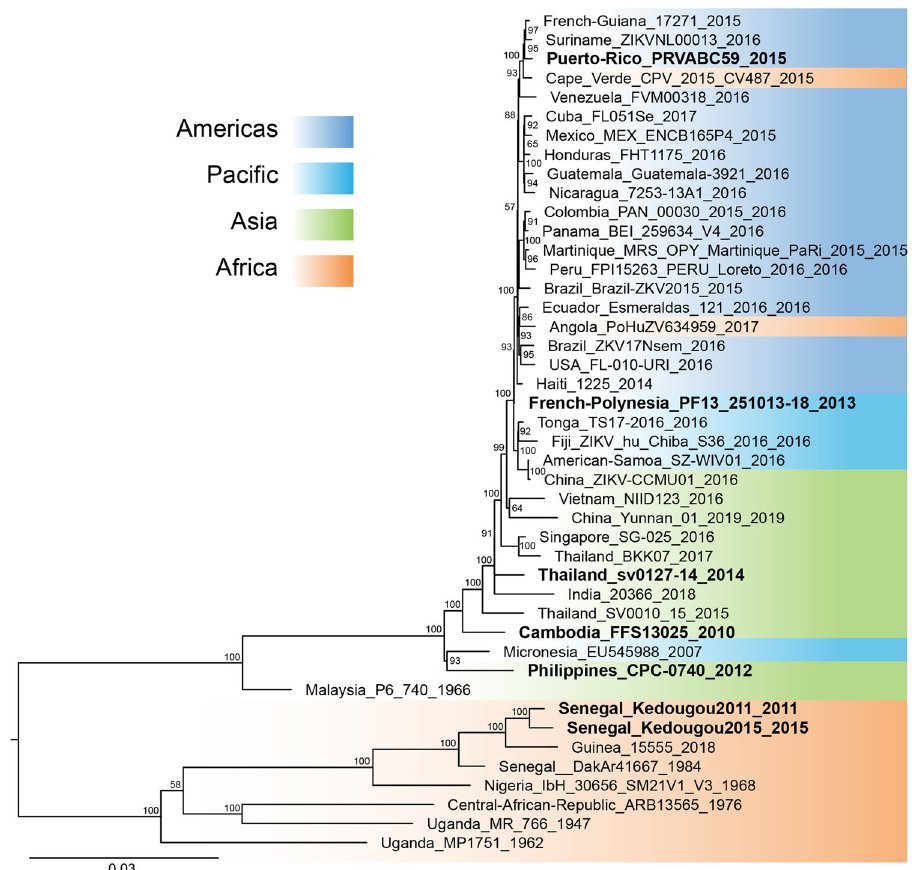
Fig. 1 Phylogenetic position of ZIKV strains used in this study. The phylogenetic tree shows the seven ZIKV strains of the panel (in bold) among a backdrop of ZIKV strains spanning the current viral genetic diversity. The colored background represents the geographic origin of ZIKV strains. The consensus tree was generated from 1000 ultrafast bootstrap replicate maximum-likelihood trees, using a GTR + F + G4 nucleotide substitution model of the full ZIKV open reading frame. The tree is midpoint rooted and the root position is veri fi ed by the Spondweni virus outgroup on amino-acid and codon- based trees. Support values next to the nodes indicate ultrafast bootstrap proportions (%) and the scale bar represents the number of nucleotide